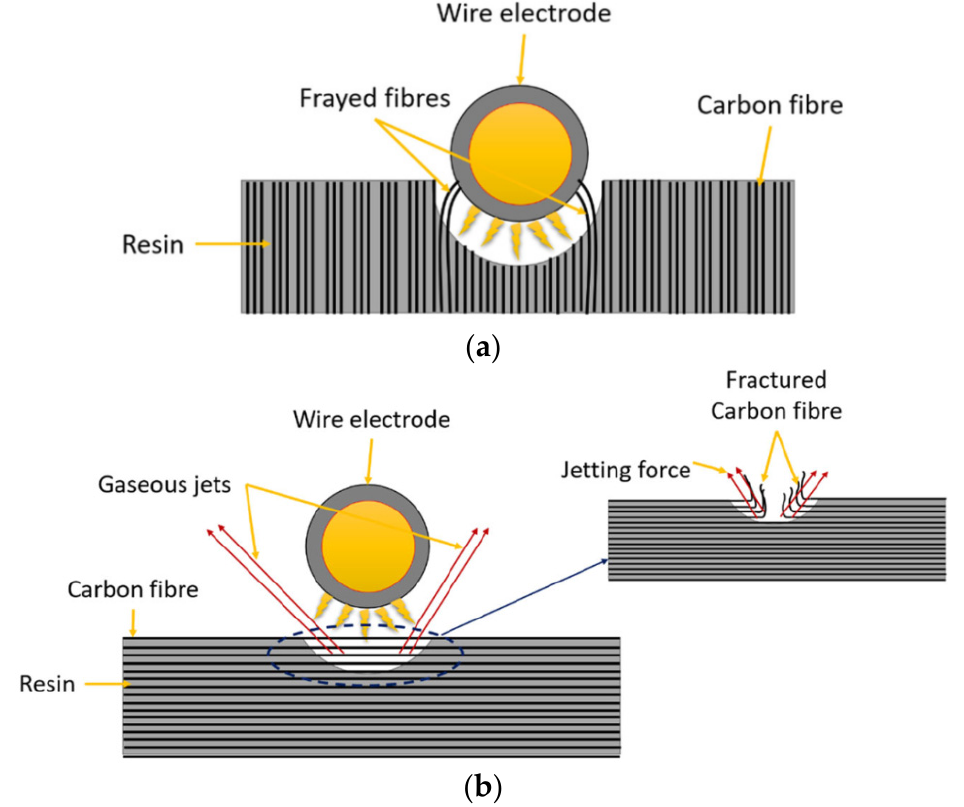
Figure 8. Schematic illustration of material removal mechanism when cutting ( a ) parallel and ( b ) perpendicular to fibre orientation. Reprinted from Ref. [118] (this is an open access arti- cle distributed under the terms of the Creative Commons CC-BY license, which permits unrestricted use, distribution and reproduction in any medium, provided the original work is properly cited).